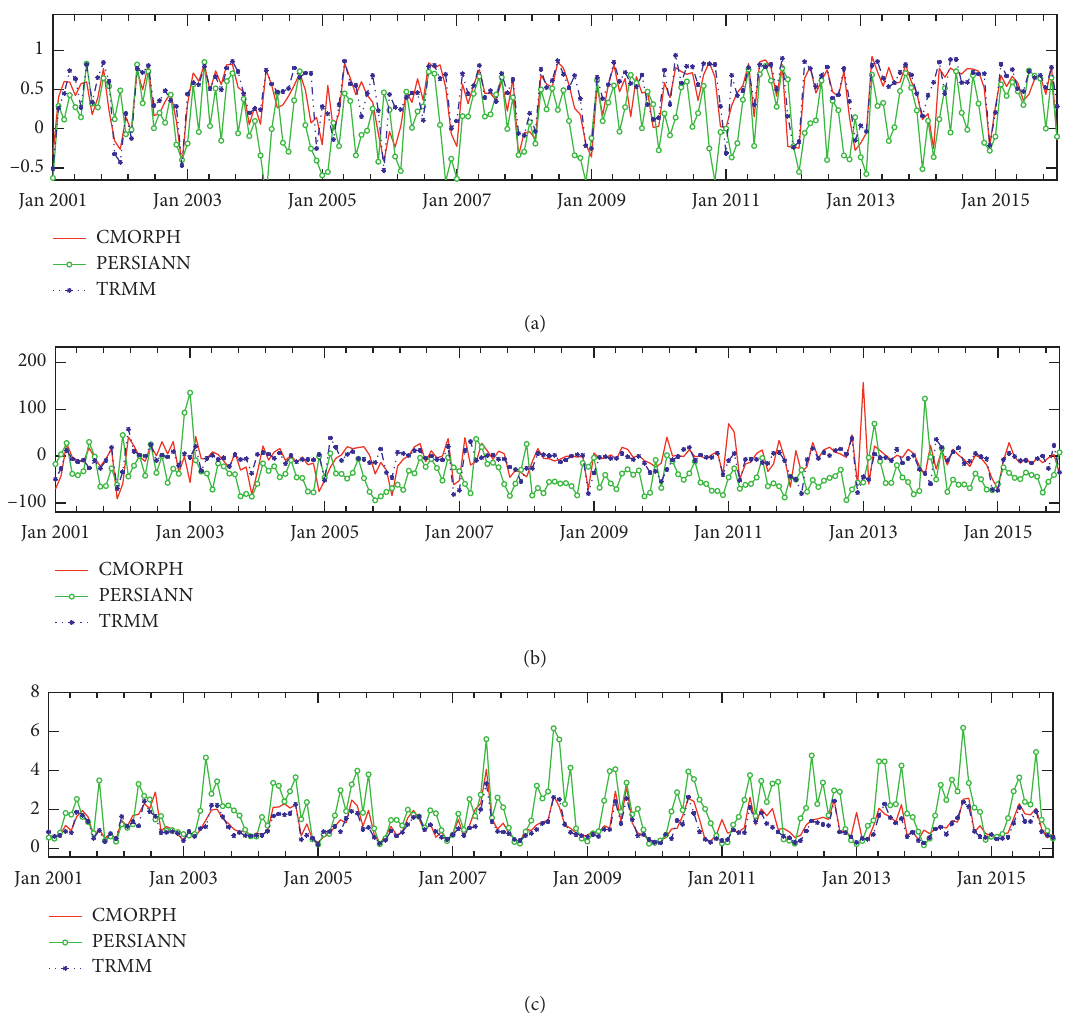
Figure 13: Time series of (a) correlation coefficient, (b) bias rate, and (c) root-mean-square error of each satellite product on a monthly